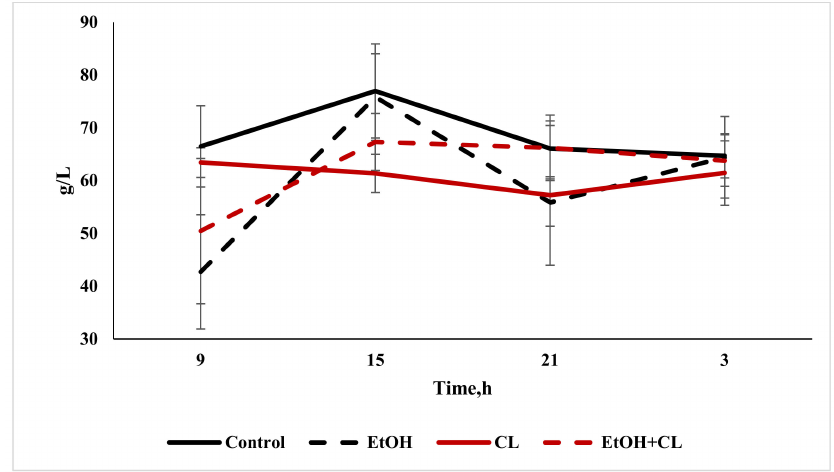
Figure 13. Daily fluctuations in total protein levels in the blood plasma of